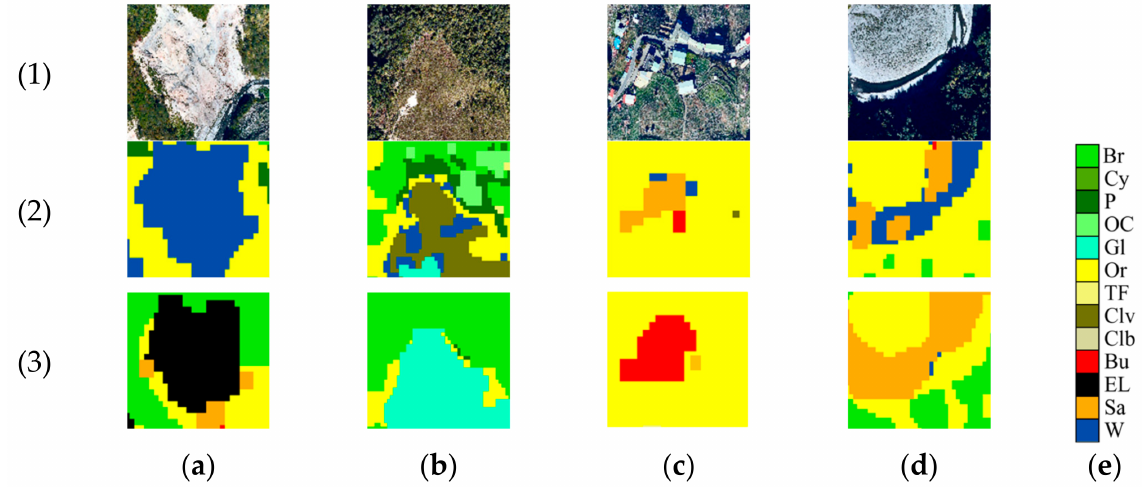
Figure 9. A close look at examples of LULC classification discrepancy in classifiers and ground truth. Images in rows (1–3) show the orthoimage and RF and SVM classified Level-III images. In ( a ), the eroded land was misclassified as water by RF but eroded land as it is by SVM. ( b ) is composed of grassland and other conifer which is classified as water, vegetated cropland, pine, broadleaf, and orchard by RF but mostly accurately classified as they are by SVM. ( c ) has built-up on the center and surrounded by orchard. Both RF and SVM recognized the orchard successfully; the built-up was mostly recognized as it is by SVM but mostly misclassified as sand by RF. ( d ) the sand was not correctly recognized by RF and SVM. ( e ) the legend of LULC